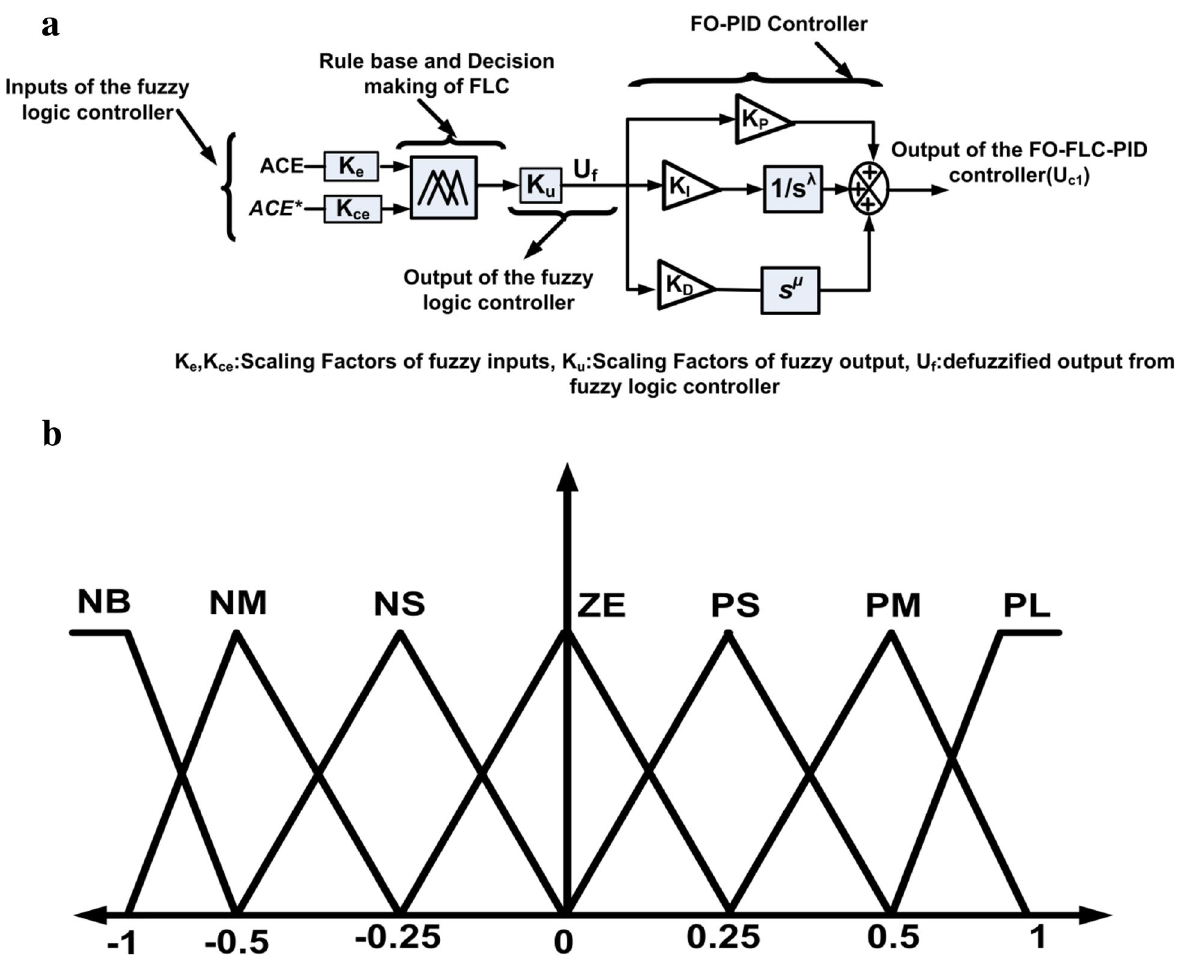
Fig. 6 a Structure of FOFPID controller, b MFs of inputs & output of FLC